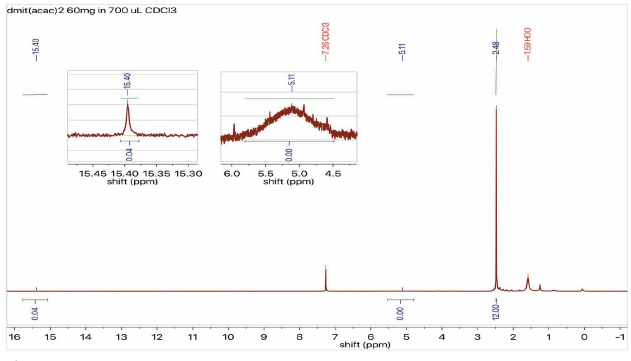
Figure 6 1 H NMR spectrum of the title compound with inserts of the baseline expansions near 15.4 and 5.1 ppm,